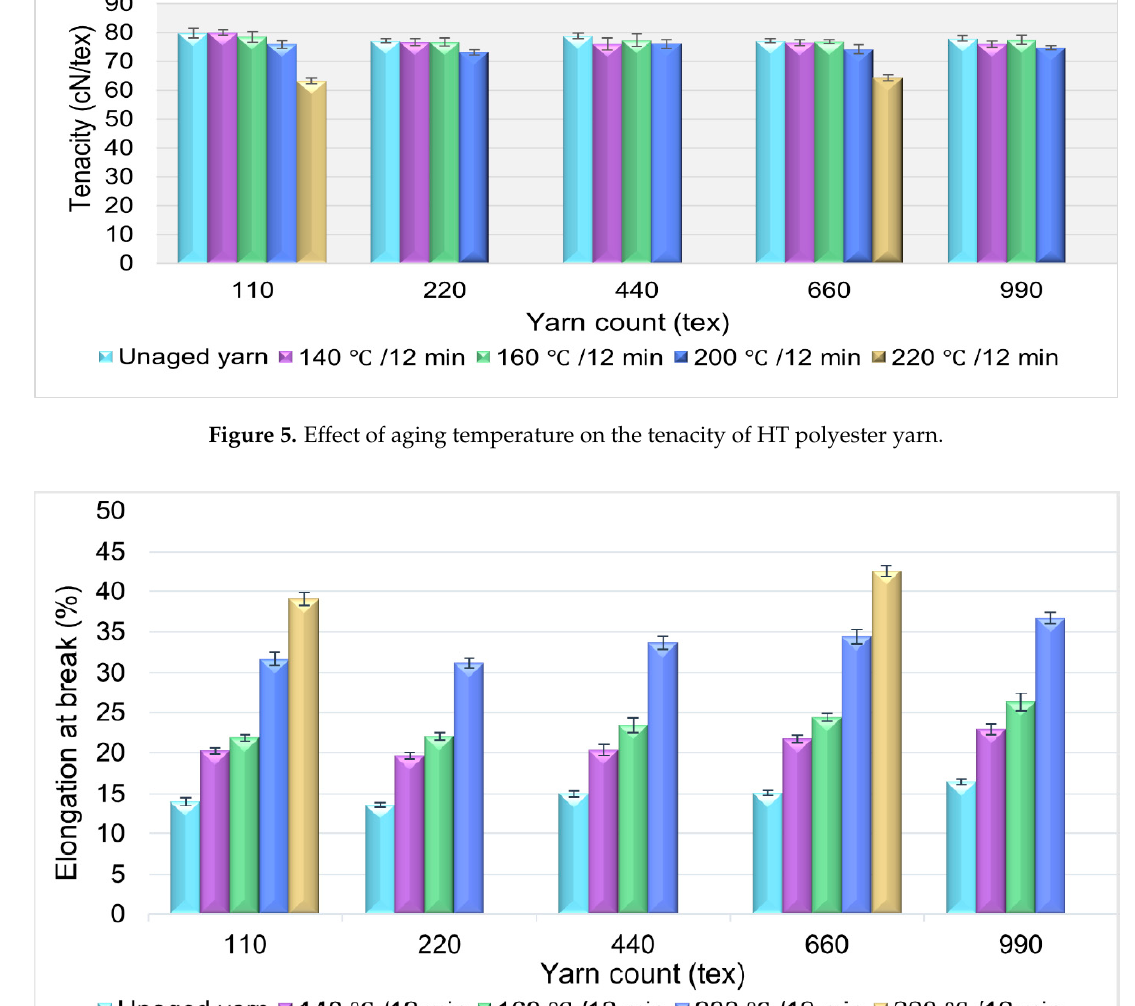
Figure 6. Effect of aging temperature on the percentage elongation of HT polyester yarn.